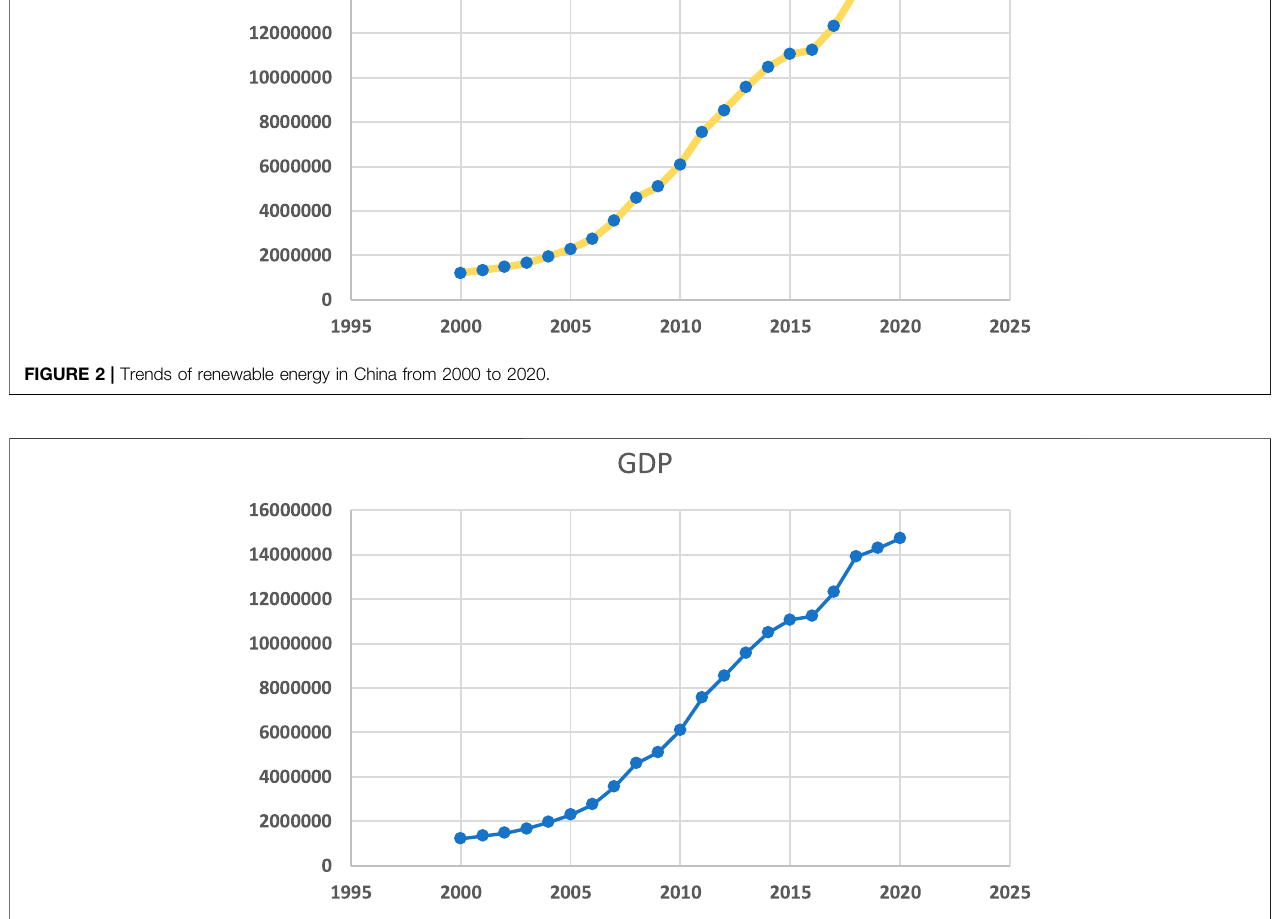
FIGURE 3 | Trends of GDP of China from 2000 to 2020.